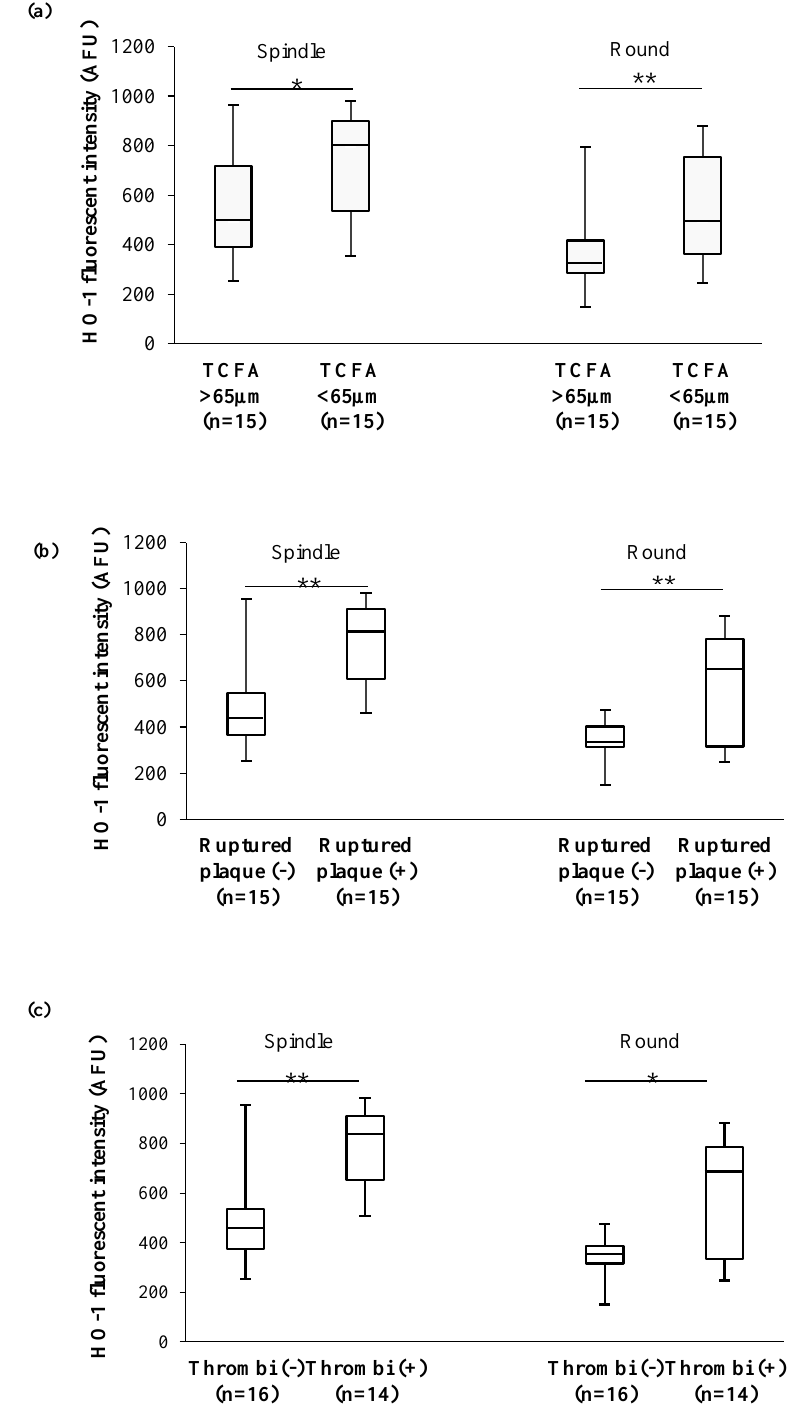
Figure 4. In vivo plaque features and HO-1 levels in MDM morphotypes. ( a ) Association between HO-1 levels and thin cap fibroatheroma (TCFA), ( b ) fibrous cap integrity, ( c ) presence of thrombi detected by means of optical coherence tomography (OCT). Data are expressed as median and IQR. * p < 0.05, ** p <